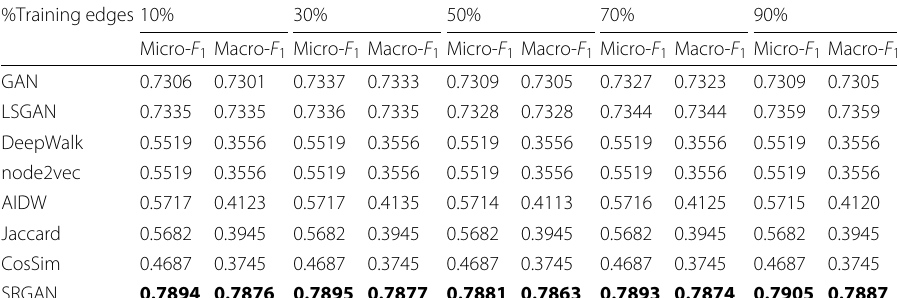
Table 3 Micro- F 1 and Macro- F 1 scores on Cora dataset in link prediction ( α = 0.3, β = 0.1)